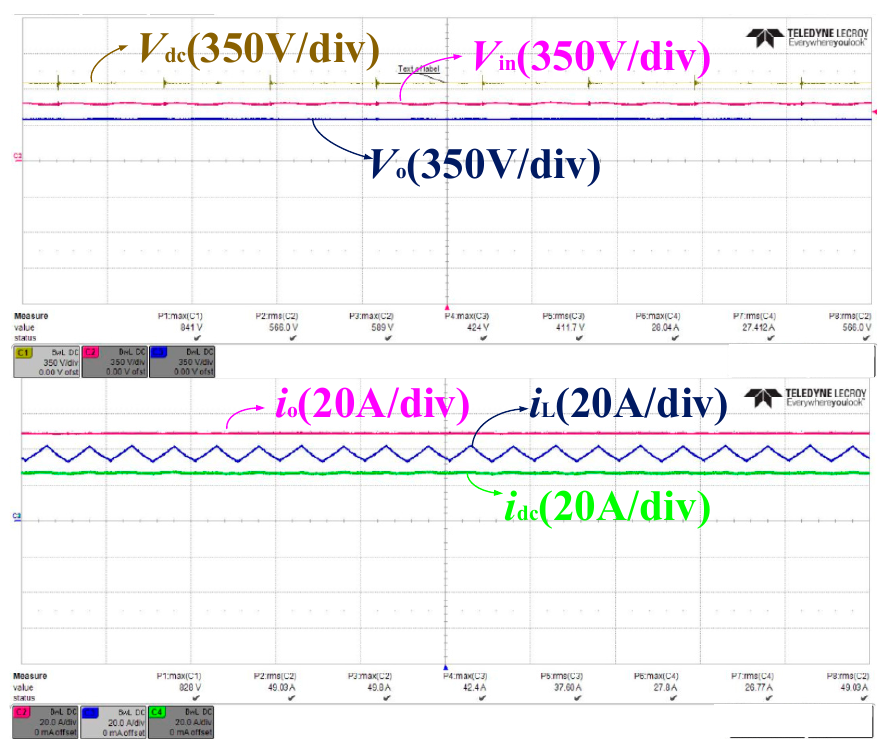
Figure 18. Experimental results of the converter in the steady-state operation.